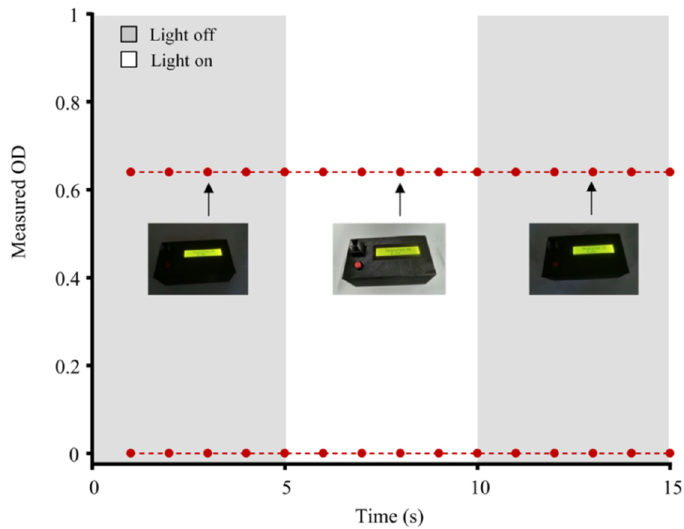
Figure 4. Effect of ambient light on the instrument. Insets were the photographs taken during the measurement.